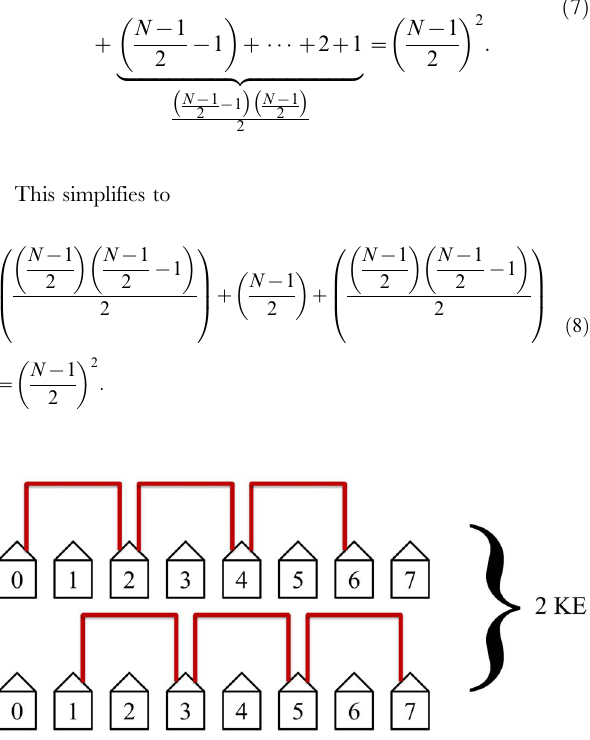
Figure 8. The second step in the protocol connects the second nearest neighbors. This step is the second quickest and the second most efficient. It has the second most non-overlapping simultaneous loops and requires 2 KEs to complete.